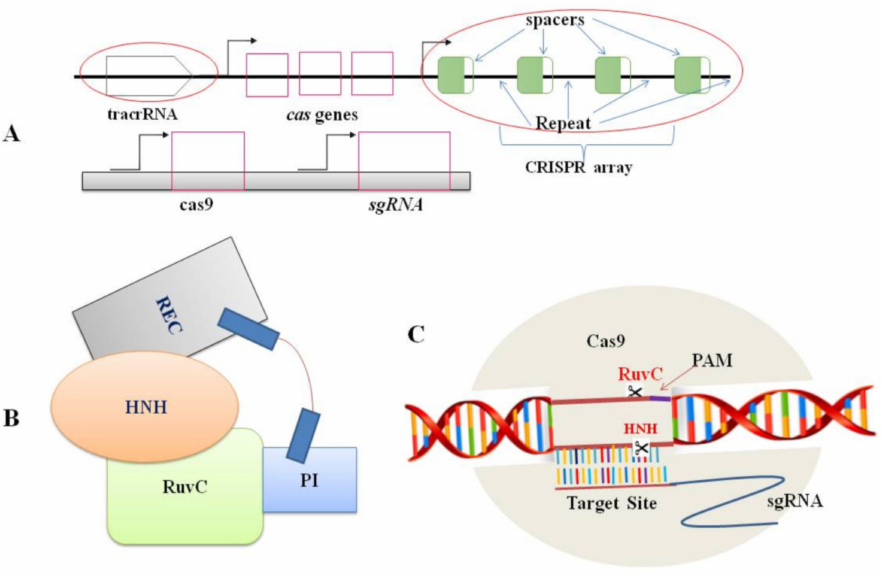
Figure 1. Components of CRISPR/Cas9 system: ( A ). Genomic structures of the CRISPR/Cas system (top) and the engineered CRISPR/Cas9 system (bottom); ( B ). A schematic representation of the Cas9 protein structure. Domains includes REC (large recognition lobe) and RuvC (a nuclease domain), which is linked with an arginine-rich region. HNH is a second nuclease domain. PI is PAM-interacting domain; ( C ). The conformation of the Cas9–sgRNA complex in the process of DNA cleavage. The Cas9 endonuclease is targeted to DNA by a guide RNA which can be supplied as a two-part system consisting of crRNA and tracrRNA or as a single guide RNA, where the crRNA and tracrRNA are connected by a linker. Target recognition is facilitated by the protospacer-adjacent motif (PAM). Cleavage occurs on both strands (scissors) 3 bp upstream of the